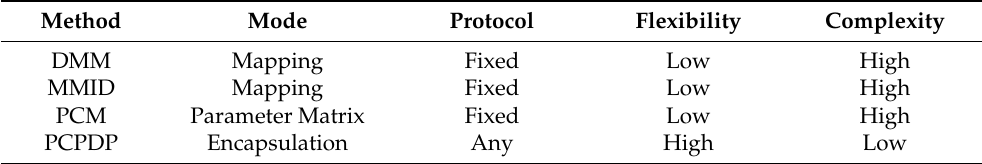
Table 1. Comparison of four protocol conversion methods. Method Mode Protocol